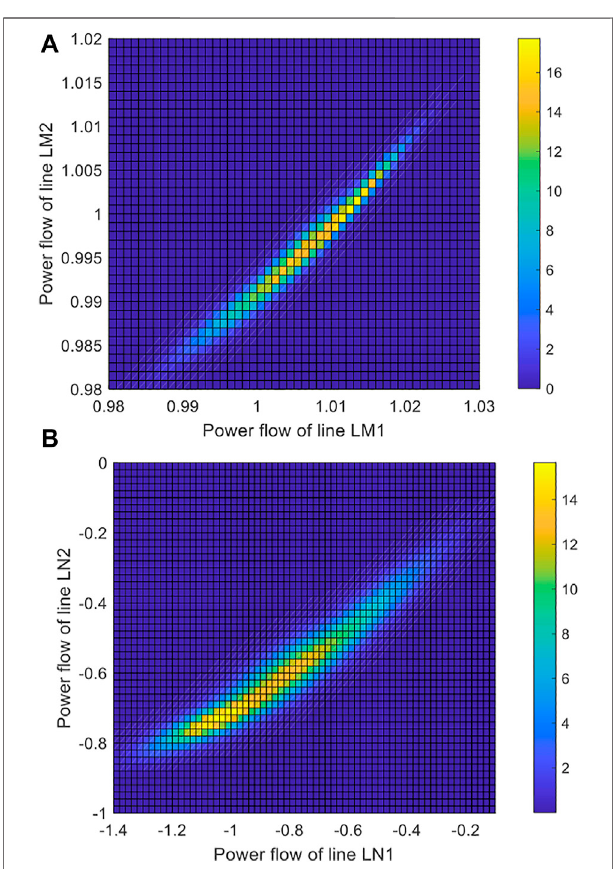
FIGURE5| Jointprobabilitydensitydistributionofpower fl owofregional important lines. (A) The joint probability density of the line LM1 and the line LM2 in area M. (B) The joint probability density of the line LN1 and the line LN2 in area N.